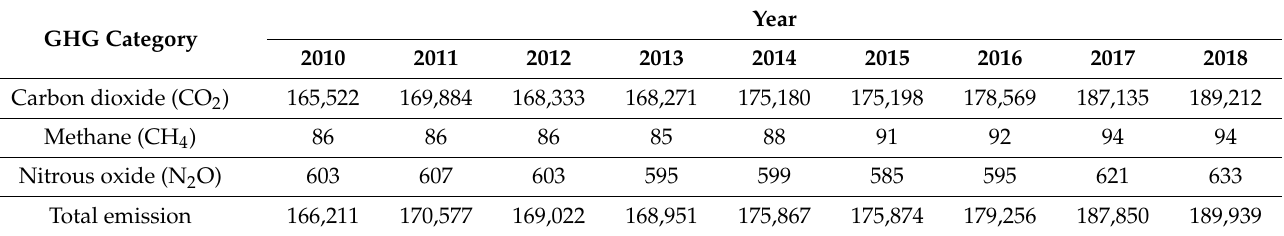
Table 2. Taiwan’s GHG emissions from the energy industries in terms of GHG sources since 2010 1 . GHG